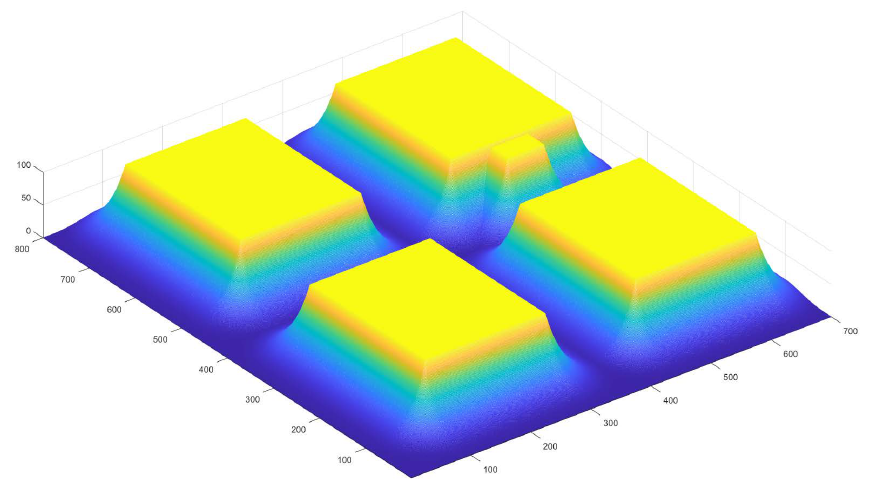
Figure 17. Repulsive potential of